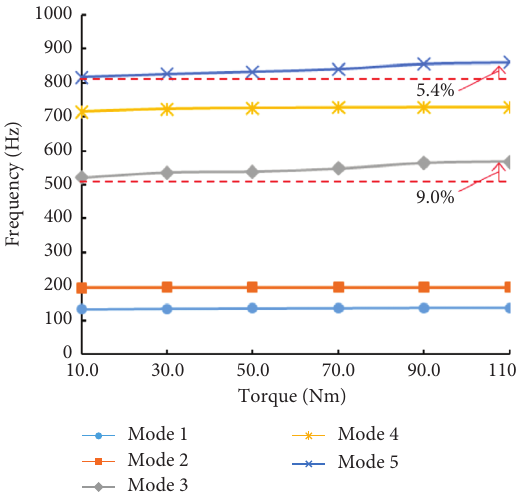
Figure 7: Natural frequency versus preload from 10 to 110Nm.